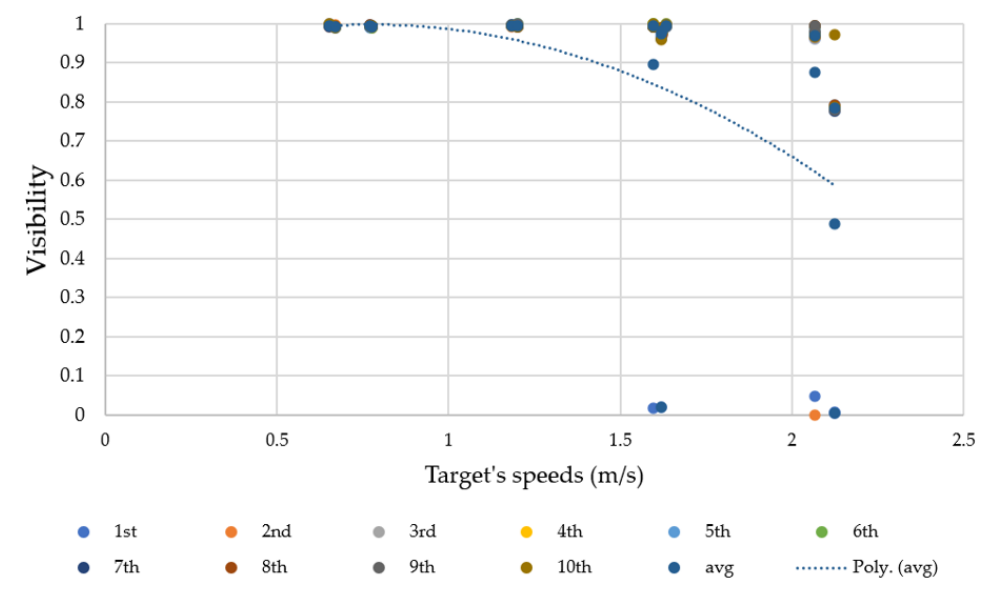
Figure 19. Relationship between visibility and target speed